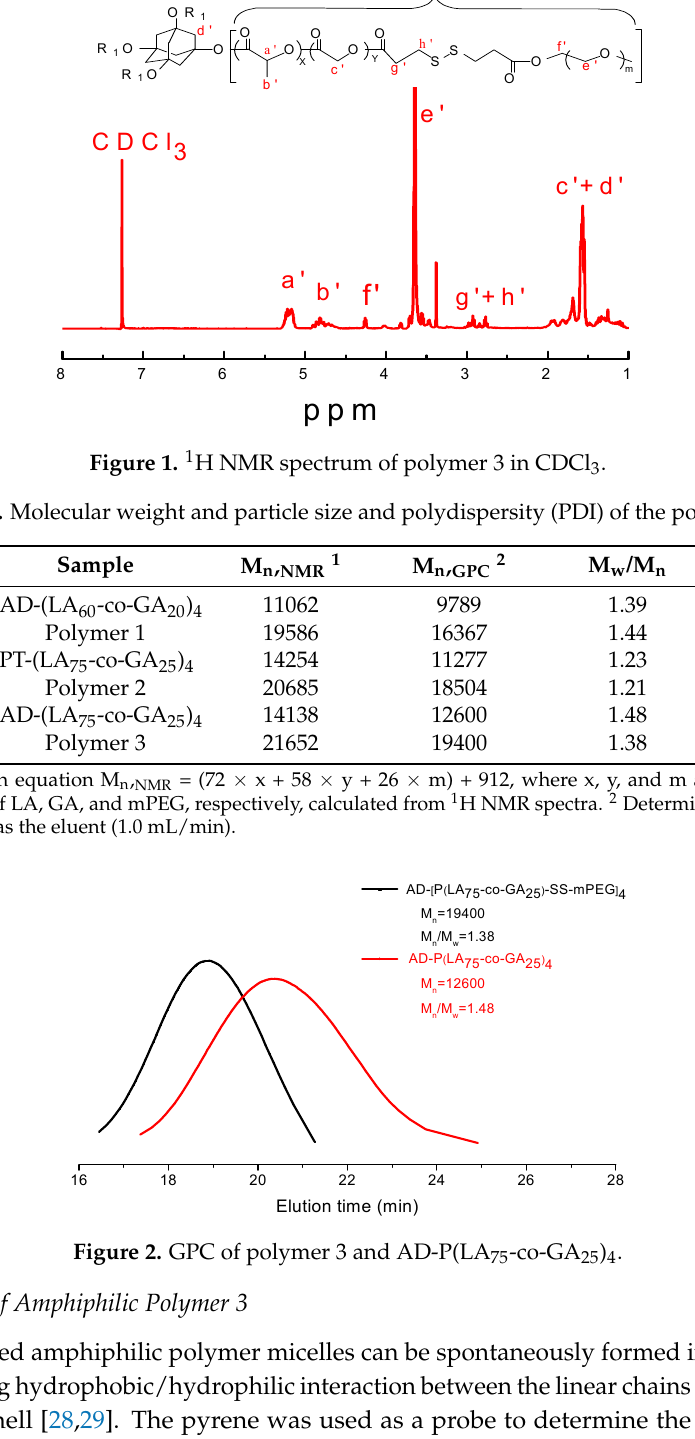
Figure 2. GPC of polymer 3 and AD-P(LA 75 -co-GA 25 ) 4 .